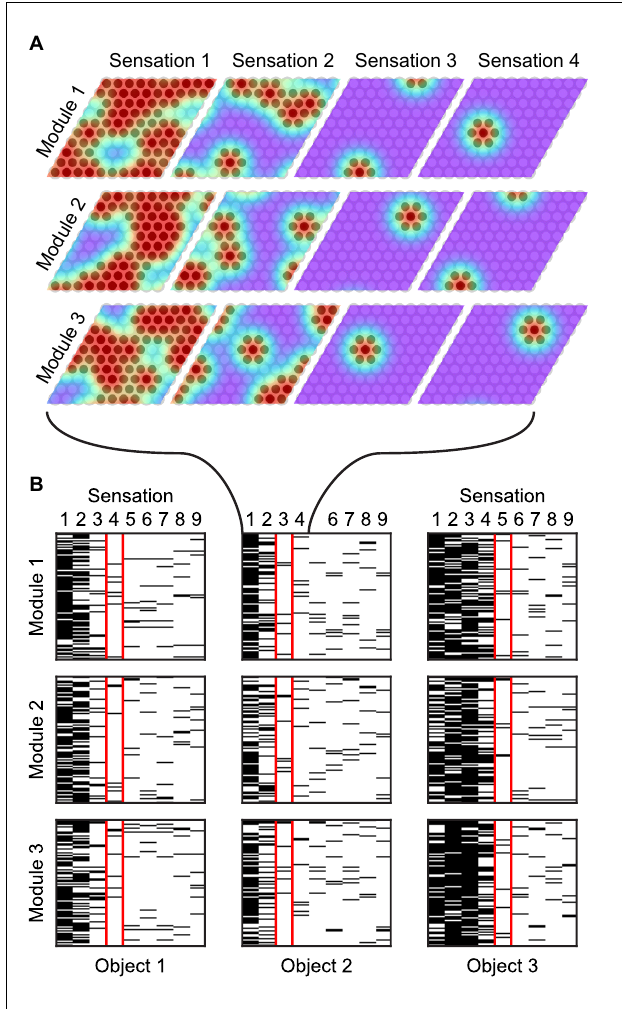
FIGURE 6 | As the network recognizes an object, it converges onto a sparse activation. (A) Location layer cell activity in three (out of 10) grid cell modules while recognizing a single object. The bumps of activity are shown in color; red indicates a high scalar activation state. The location representation, shown as darkened circles, consists of cells that are sufficiently active. Each movement shifts the activity and each sensation narrows the activity to the cells that predict the new sensation. Cell activity converges onto a sparse representation by Sensation 3 and remains sparse afterward. (B) Cell activity in the same three modules as (A) , shown for additional sensations and for two additional objects. Each module has 100 cells. The black lines indicate that the cell is active during the indicated sensation. After the first sensation, the location codes are very ambiguous in all cases. Depending on how common the sensed features are, the module activity narrows at different rates for the different objects. The sensation highlighted in red shows the first step in which the object is unambiguously determined. From this point on, the module activity shifts with each movement but remains unique to the object being sensed (These simulations used a unique feature pool of size